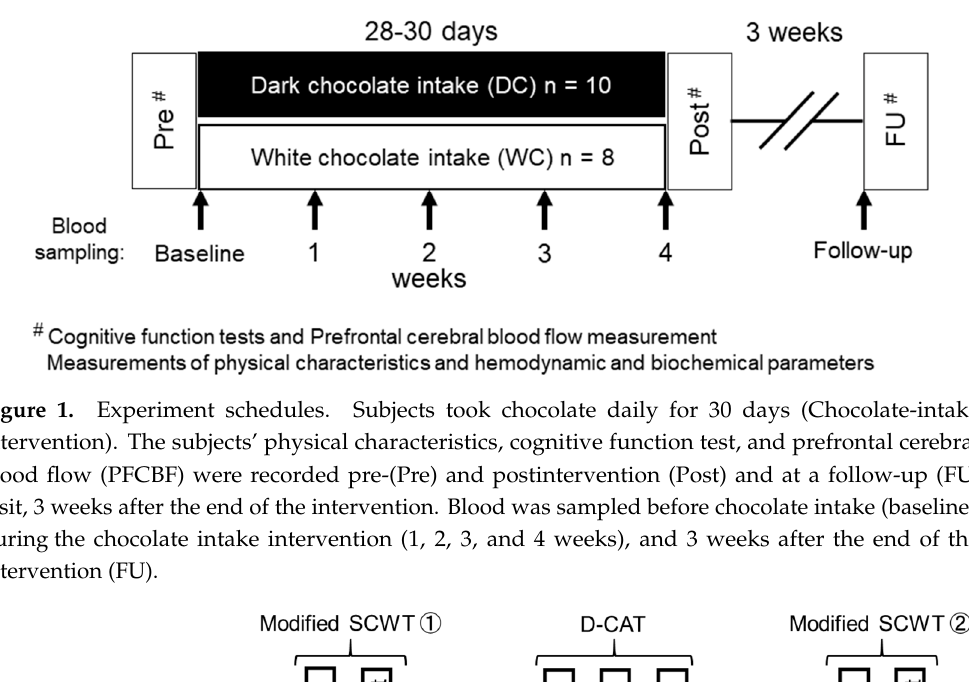
Table 1. Nutritional components of dark chocolate (DC) and white chocolate (WC).